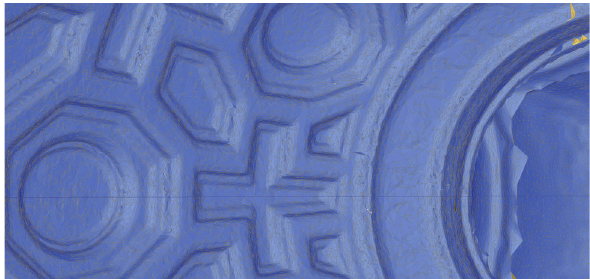
Figure 4. Detail of range based triangulated